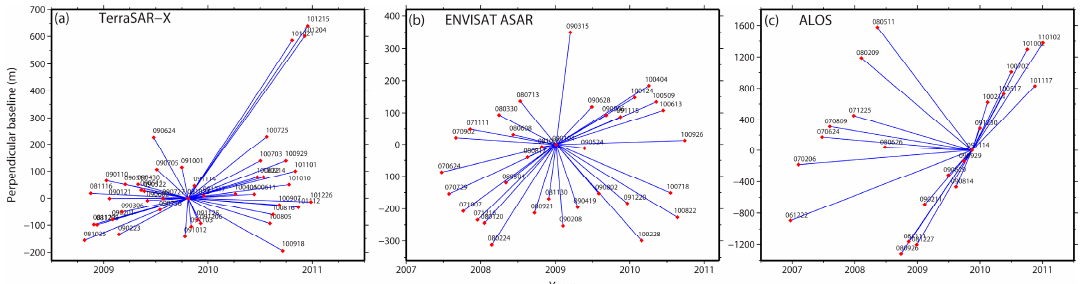
Figure 2. Spatial and temporal baseline distributions for: X ( a ); C ( b ); and L ( c )